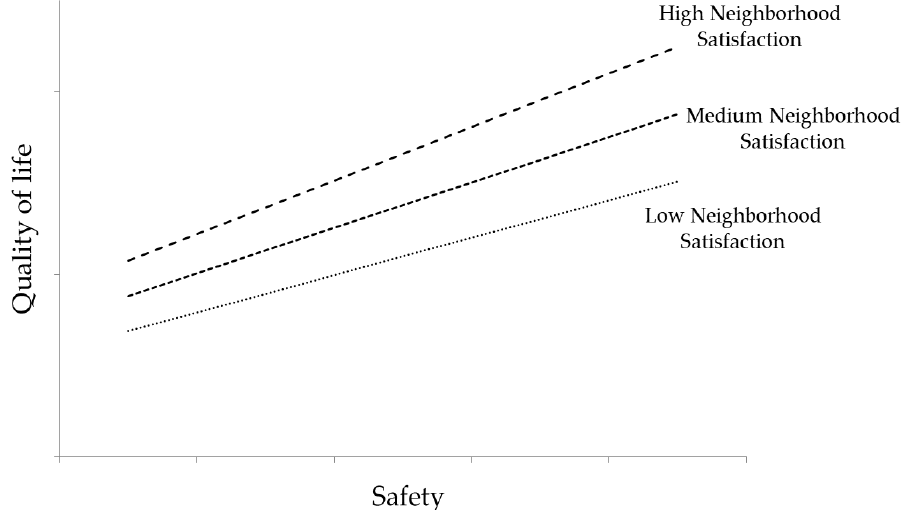
Figure 4. Moderating effect of neighborhood satisfaction on safety and